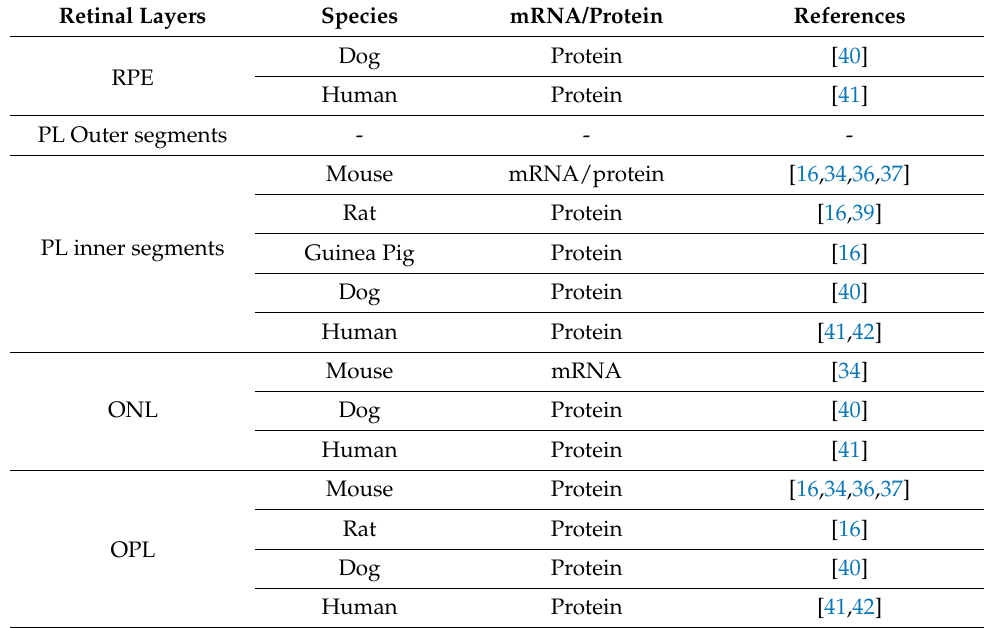
Table 1. Summary of NGB mRNA/protein expression in retinal layers among different